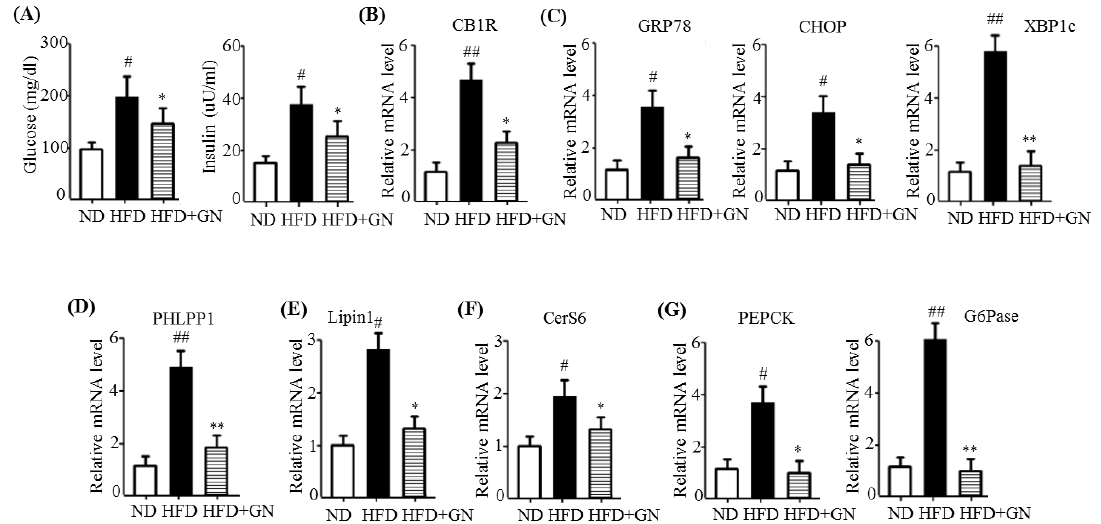
Figure 6. GN ameliorated high-fat diet (HFD)-induced hyperglycemia through inhibition of hepatic CB1R signaling. C57BL6 mice were fed HFD for 12 weeks and orally administered GN for 6 weeks. ( A ) Fasting levels of glucose and insulin. qPCR analysis of CB1R ( B ), GRP78 , CHOP , and XBP1c ( C ), PHLPP1 ( D ), Lipin1 ( E ), CerS6 ( F ), and PEPCK and G6Pase ( G ). The values are expressed as mean ± SEM ( n = 5 mice per group). # p < 0.05, ## p < 0.01 vs. ND mice. * p < 0.05, ** p < 0.01 vs. HFD-induced obese mice control. ND; normal diet.